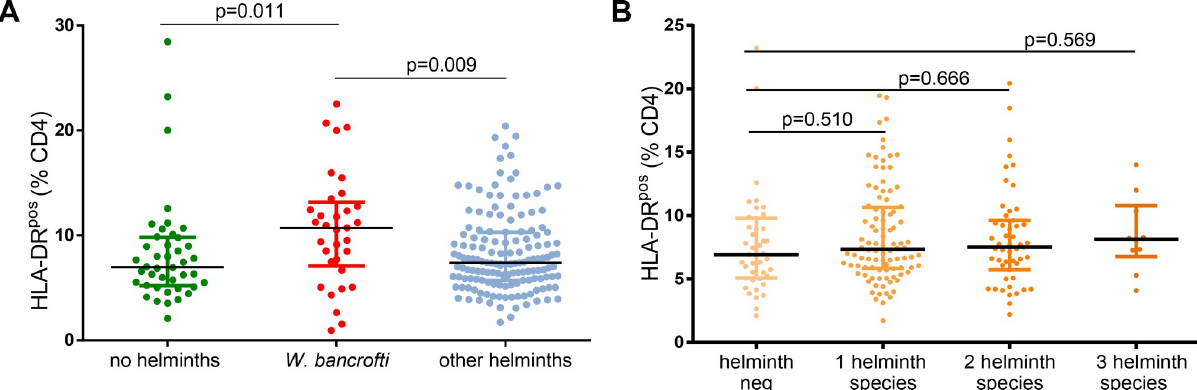
Fig 3. A: Expression of HLADR on CD4 T cells in relation to the helminth infection status. The percentage of HLADR expressing CD4 T cells is shown for the three categories of participants. Kruskal-Wallis testing showed significant difference between groups overall (p = 0.0168). W . bancrofti- infected individuals had significantly more HLADR expressing CD4 T cells compared to helminth free individuals or study participants infected with other helminths as shown by Mann-Whitney test. B: Association of polyparasitism with activation status. Number of eosinophils is shown for participants with increasing numbers of helminth species. Kruskal-Wallis testing showed no significant difference between groups (p = 0.917) as well as Mann-Whitney